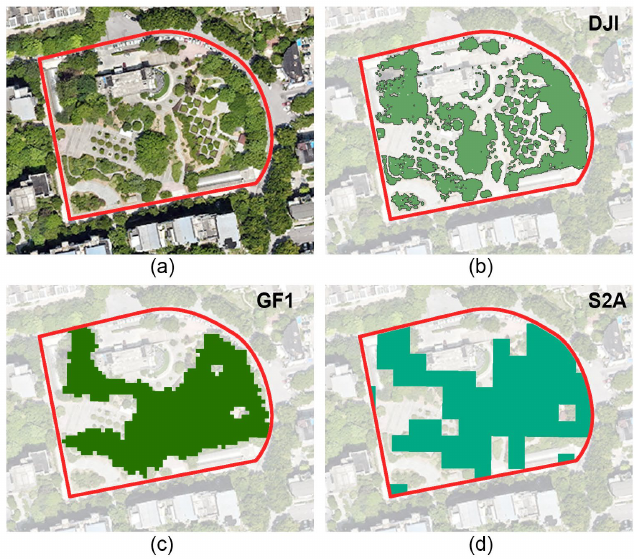
Figure 8. The comparison of extracting UGS from data with different resolutions ( a ) the visible light image taken by DJI; ( b ) UGS extracted from DJI; ( c ) UGS extracted from GF1; ( d ) UGS extracted from S2A.